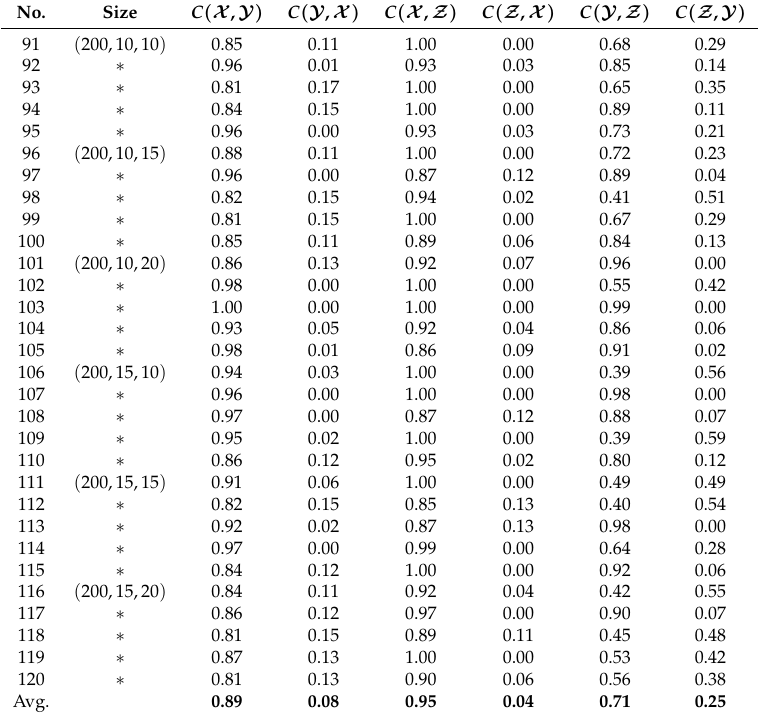
Table 11. Coverage metrics for comparing the algorithms on the test instances with 200 cars.